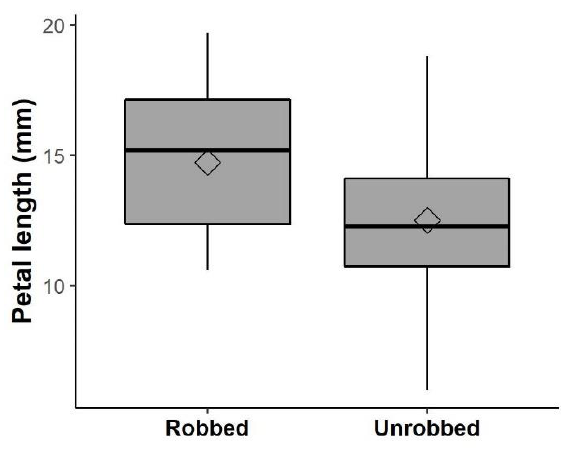
Figure 6. Boxplot of petal length (+/- SE) of flowers that were robbed (with a bitten hole in the corolla tube) or unrobbed across all sites. Diamonds represent mean values (unrobbed N = 535, robbed N =